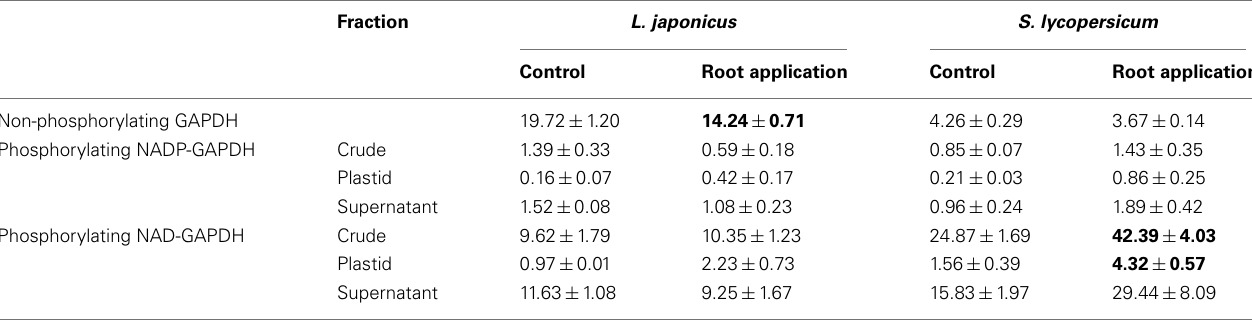
Table 3 | Specific GAPDH activity in lotus and tomato roots upon lumichrome treatment assayed under non-phosphorylating and phosphorylating